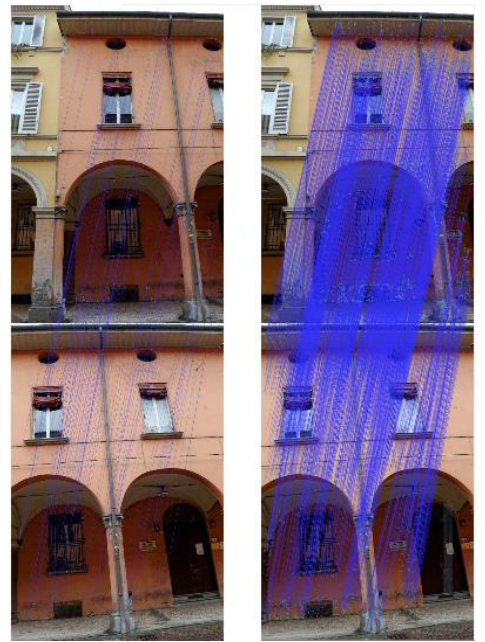
Figure 4. Tapioca feature extraction and matching results with different image pre-processing algorithms. Contrast preserving decolorization - 111 matches (left) and Wallis filter - 1814 matches (right).